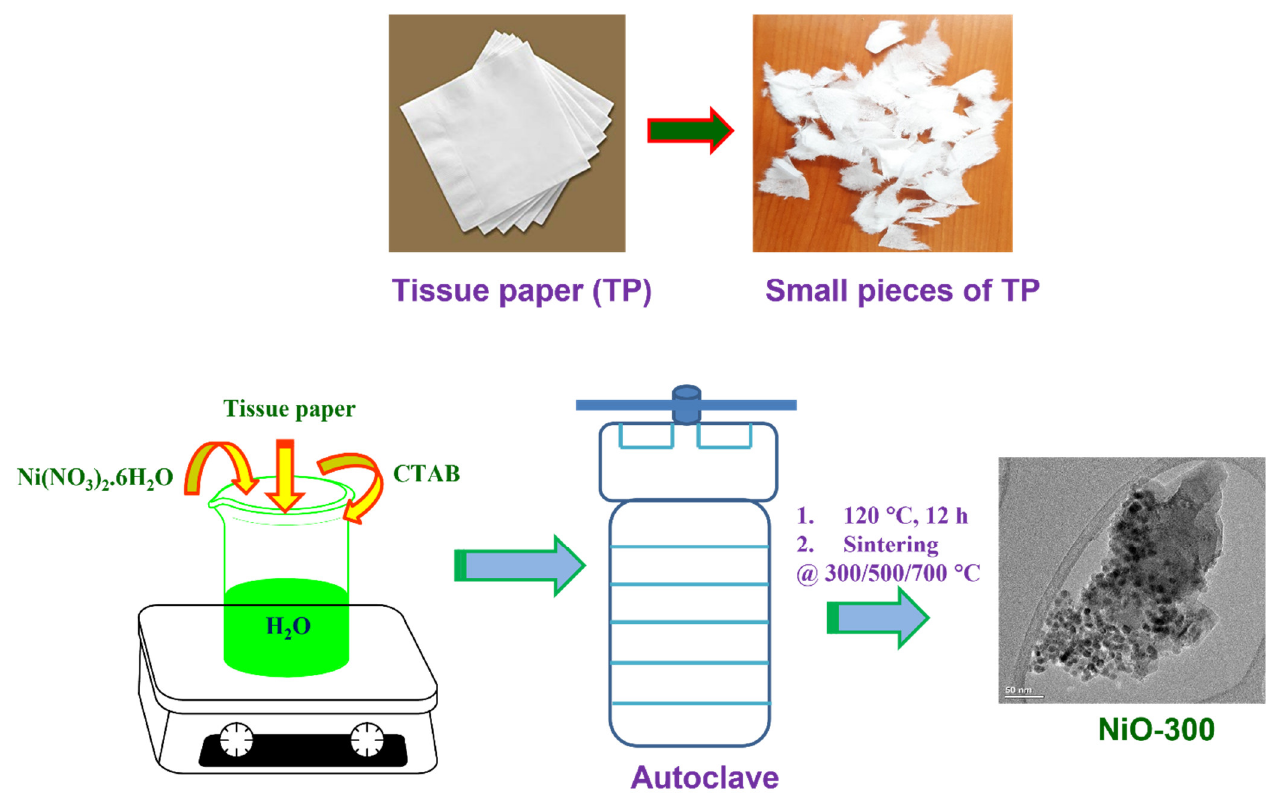
Figure 1. Pictorial representation of the reaction protocol of nickel oxide nanoparticles.